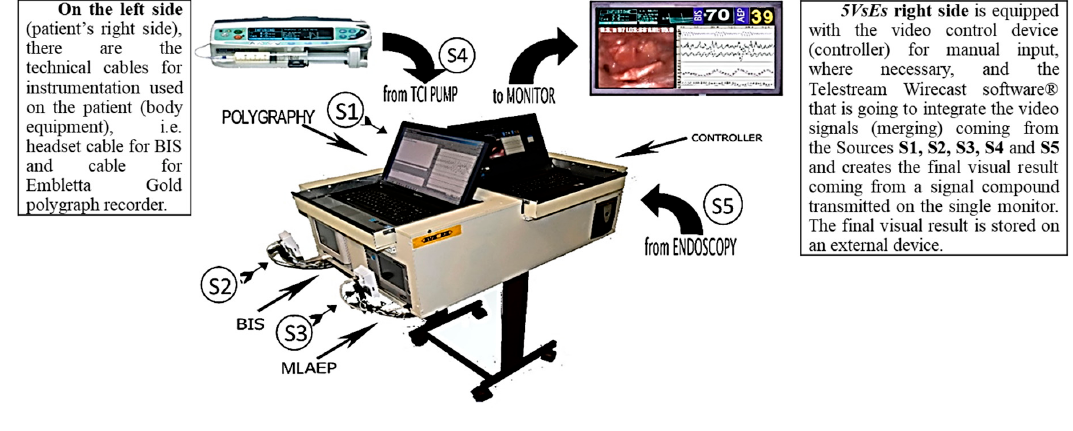
Figure 1. Detailed description of the Experimental 5 Video Stream System (5VsEs ) .